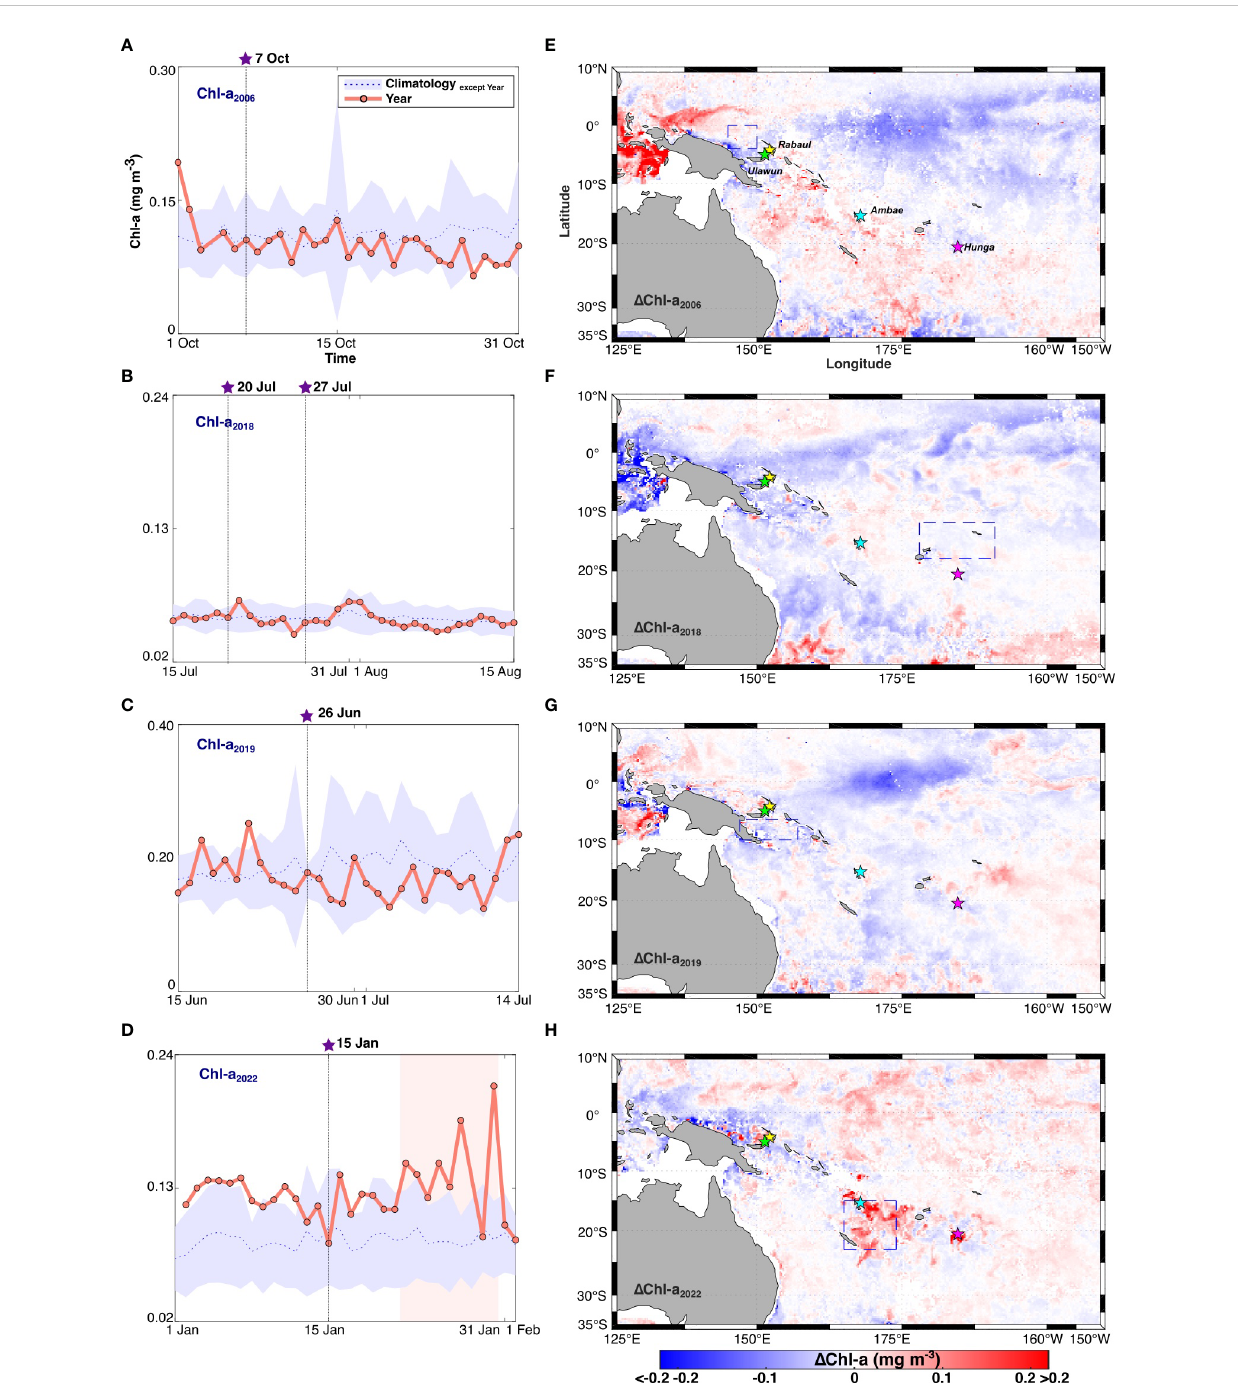
FIGURE 4 The area-averaged time series of Chl-a (red markers) over the distal region in (A) 2006 (0 – 4°S, 145 – 150°E), (B) 2018 (12 – 18°S, 178°E – 169°W), (C) 2019 (6.5 – 10°S, 147 – 157°E), and (D) 2022 (15 – 23°S, 165 – 174°E). Each region is shown as blue box in Figure 2. The blue dotted line indicates the area-averaged climatological mean and blue shading indicates one standard deviation of climatological mean. Star markers indicate main volcanic eruptions. The red shading indicates a Chl-a response subsequent to 2022 Hunga event. The spatial distribution of D Chl-a for the period of (E) 13-22 October, 2006, (F) 2-11 August, (G) 2-11 July, 2019 and (H) 21-30 January, 2022. D Chl-a is difference of Chl-a year and Chl-a climatology except year for corresponding each period,